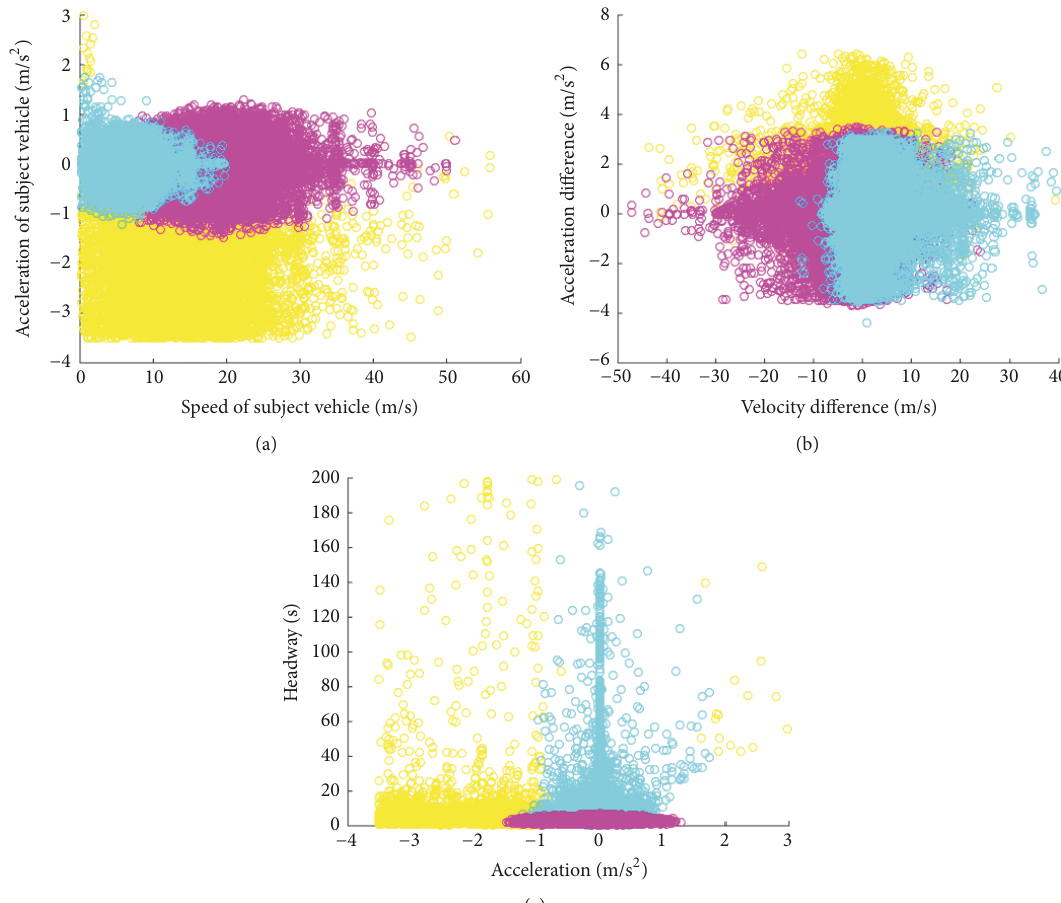
Figure 3: Driving types clustered under the condition of congested